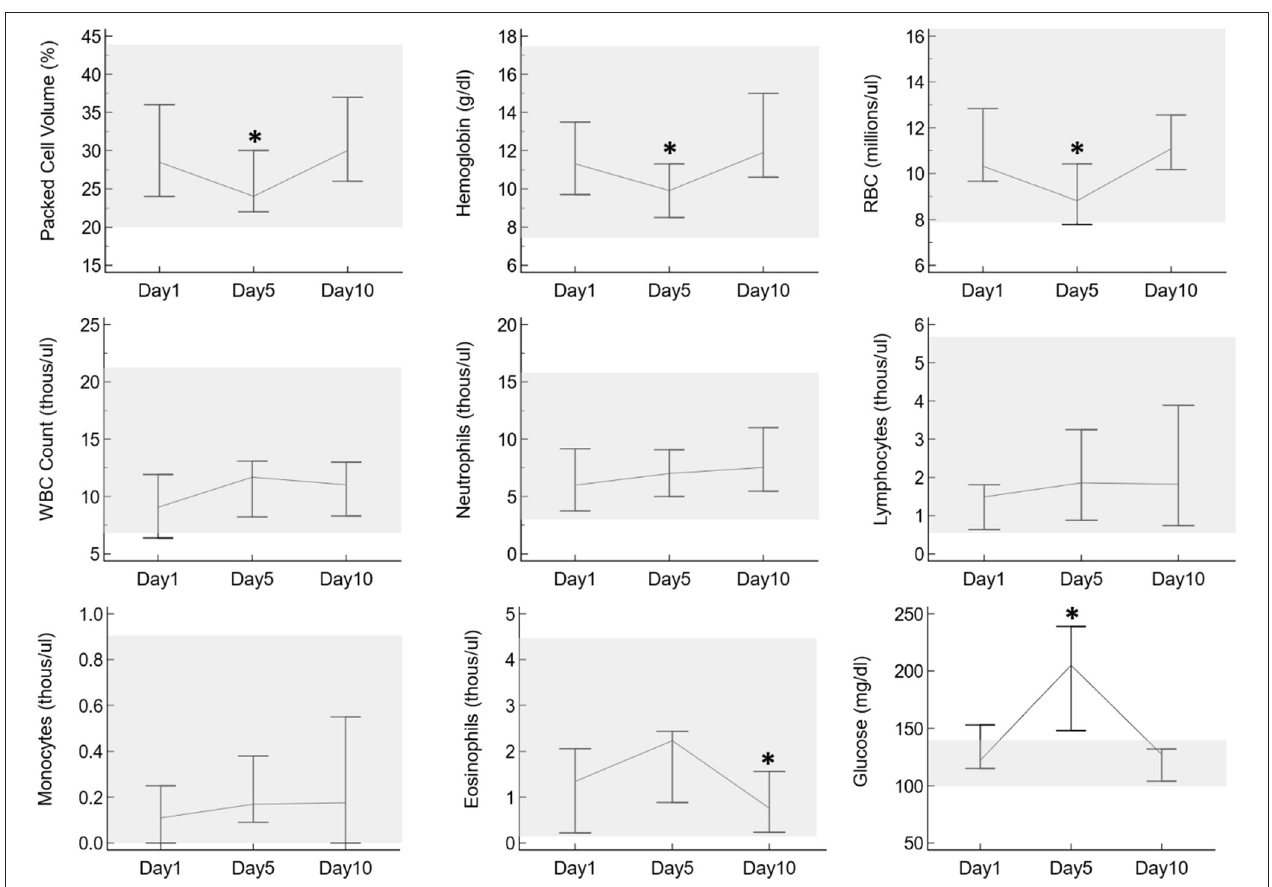
FIGURE 3 | Selected CBC and plasma biochemistry results from six alpacas before oral prednisolone (day 1), after 5 days of oral prednisolone (day 5), and after a 5-day post-administration washout (day 10). The vertical lines indicate the range of results for each day, with lines connecting at the medians. The gray shaded boxes highlight the reference interval for each parameter as established for alpacas in the UTVMC clinical pathology laboratory. Asterisks indicate days in which results are significantly different from the other two days.